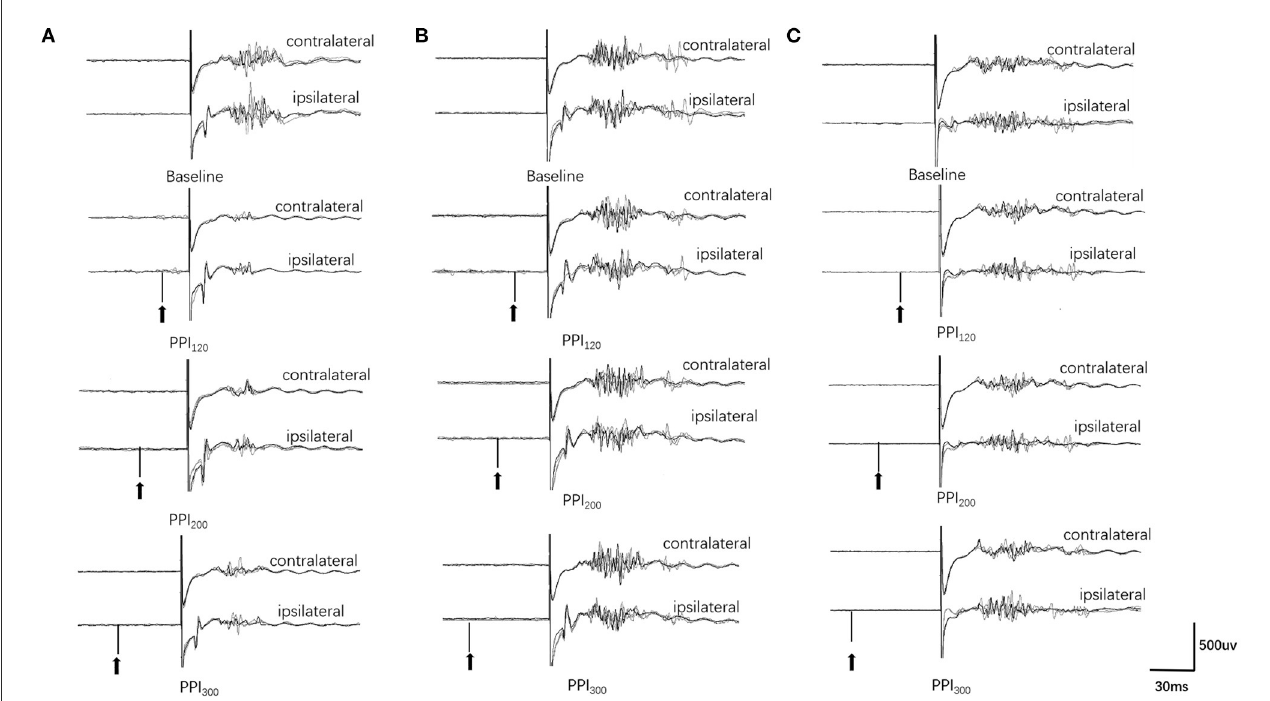
FIGURE1 Prepulse inhibition of the blink reflex in the HC and BSP groups (with and without sensory tricks). (A) HC group, (B) NST group, (C) ST group. PPI 120 , prepulse inhibition at ISIs of 120ms; PPI 200 , prepulse inhibition at ISIs of 200ms; PPI 300 , prepulse inhibition at ISIs of 300ms. The upper two traces represent the baseline blink reflex (without a prepulse stimulus), while the lower six traces represent the blink reflex after a prepulse stimulus (arrow indicates prepulse stimulus to the index finger). Each trace represents the superposition of four blink reflexes. BSP patients had greater R 2 and R 2c